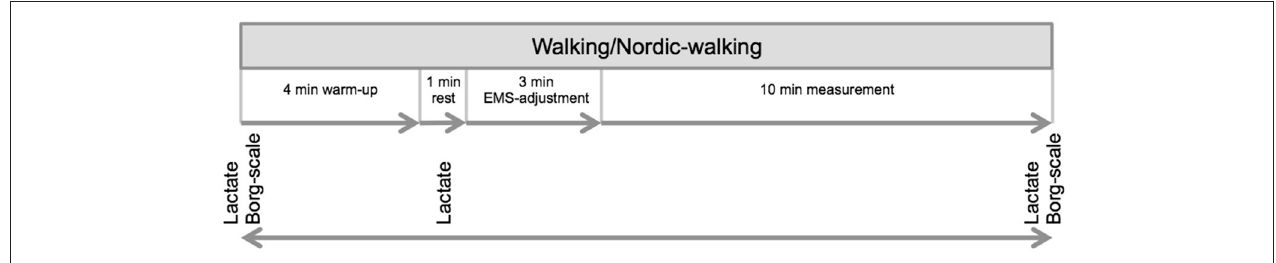
FIGURE 1 | Study design. The study consisted of overall four appointments, one appointment for medical examination and first measurement and three more measurement appointments. An interval of 1 week between each measurement was implemented. During the four measurements, each condition (conventional walking, electrical muscle stimulation (EMS)-supported W, conventional Nordic walking, and EMS-supported Nordic walking) was performed in random order.